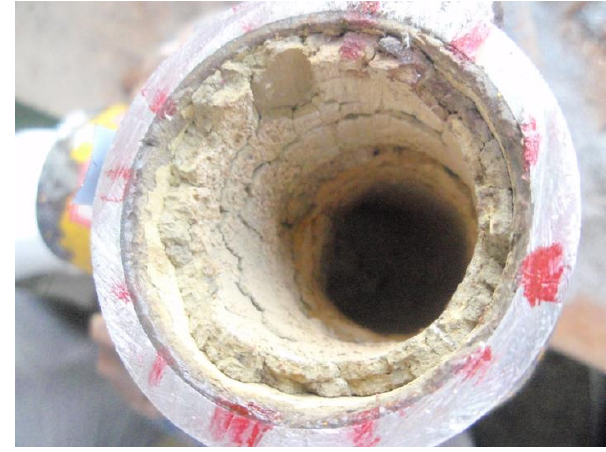
Figure 3. Serious corrosion in the pipe.